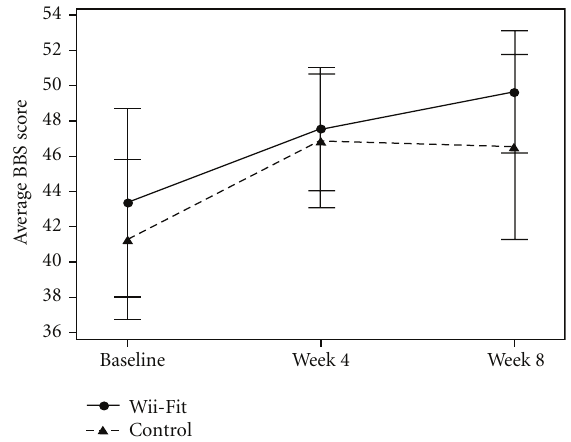
Figure 2: Comparison of mean change in BBS ∗ between the Wii- Fit and walking groups. ∗ BBS: Berg Balance Scale; Data points represent means and error bars represent ± 2